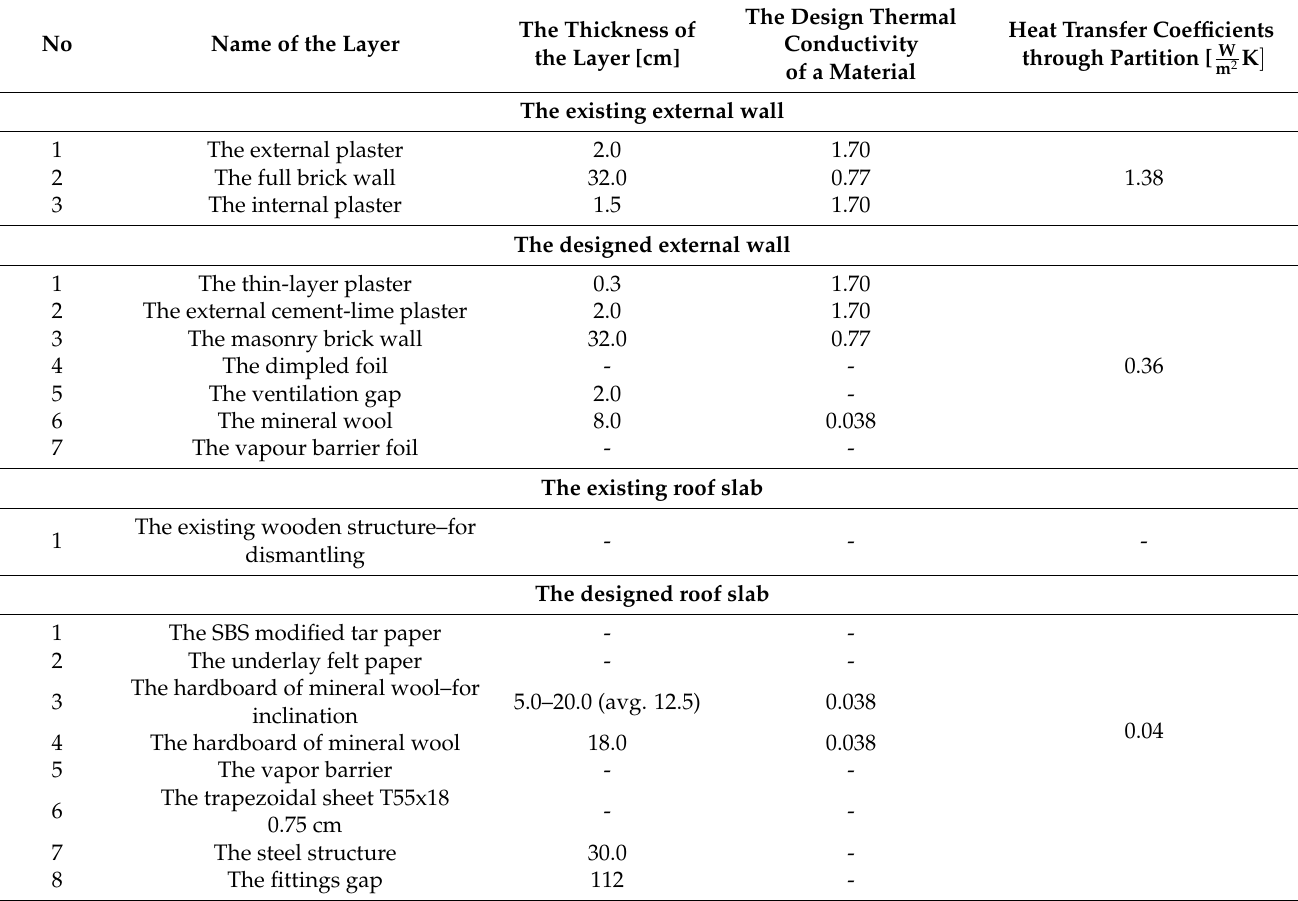
Table 4. The thermal modernisation building solutions for the restaurant pavilion in the Centennial Hall complex (elaborated by the Authors based on